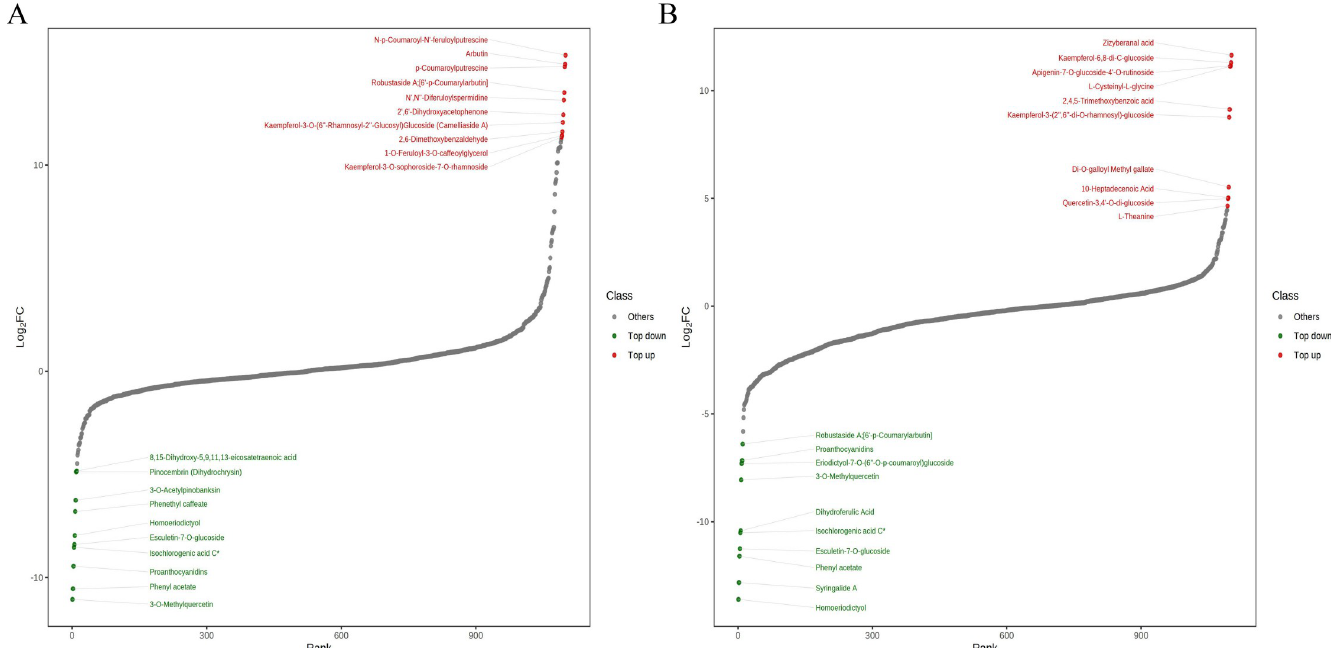
Fig 7. Dynamic distribution diagram of differences in metabolite content. A. Pl-P vs. Pl-SP. B. Pl-S vs. Pl-SP.